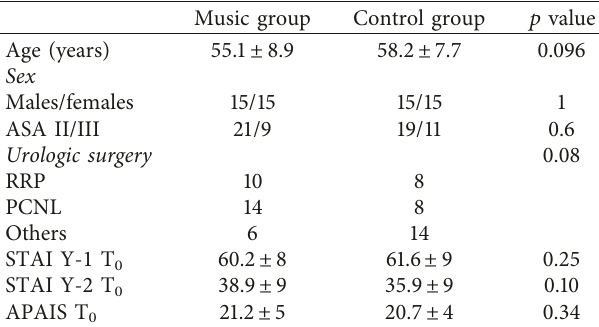
Table 1: Demographic and psychological tests.